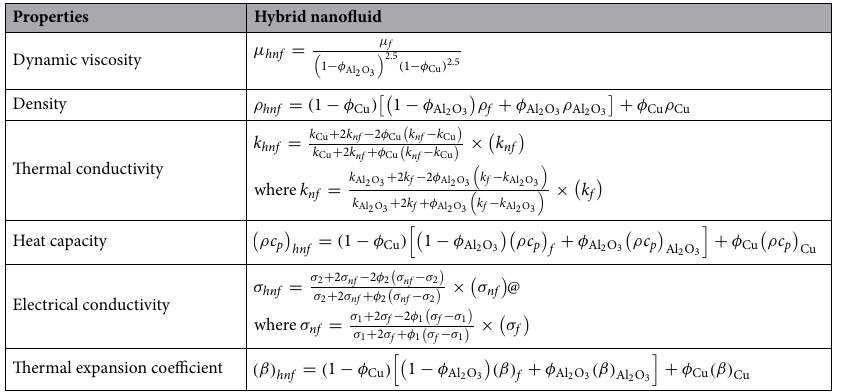
Table 1. Thermophysical features of hybrid nanofluid 20,21 .